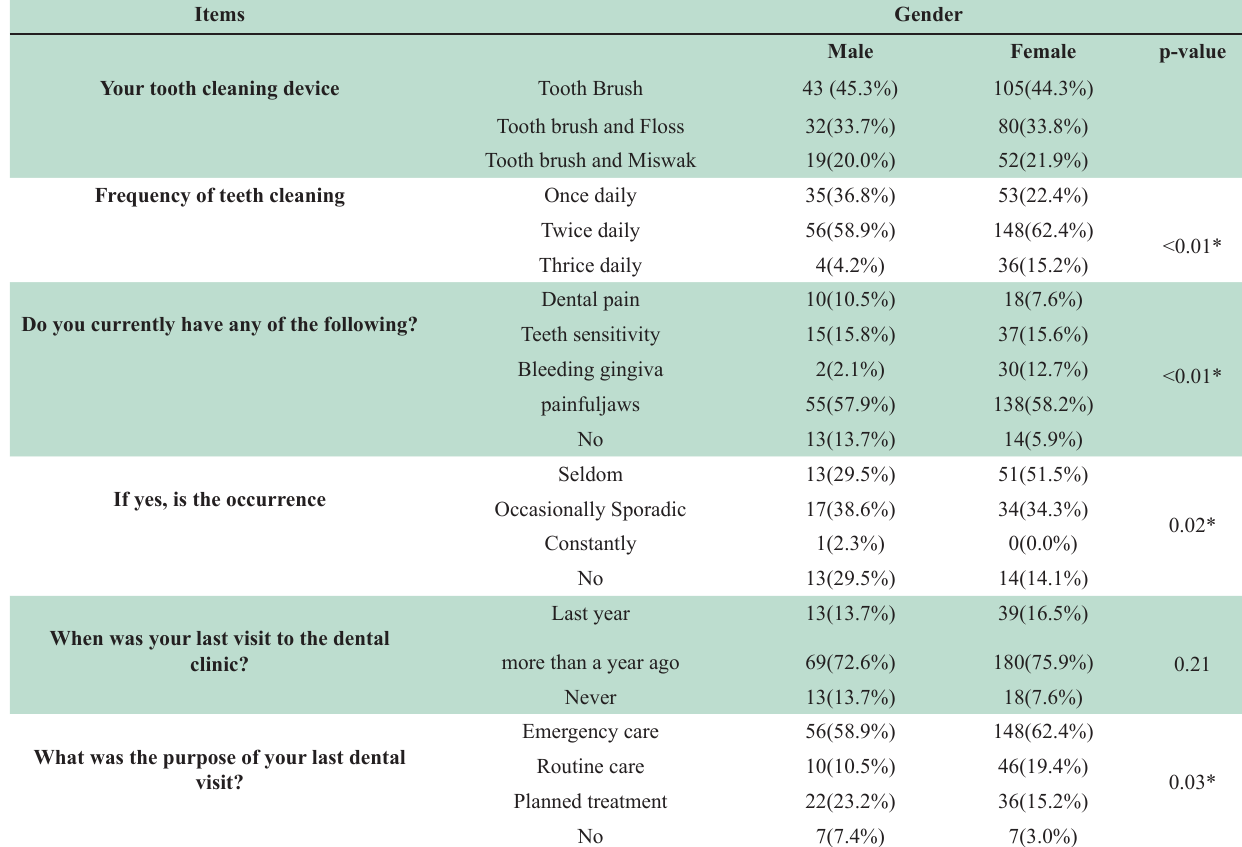
Table-IV: Association of Dental Practices with respect to